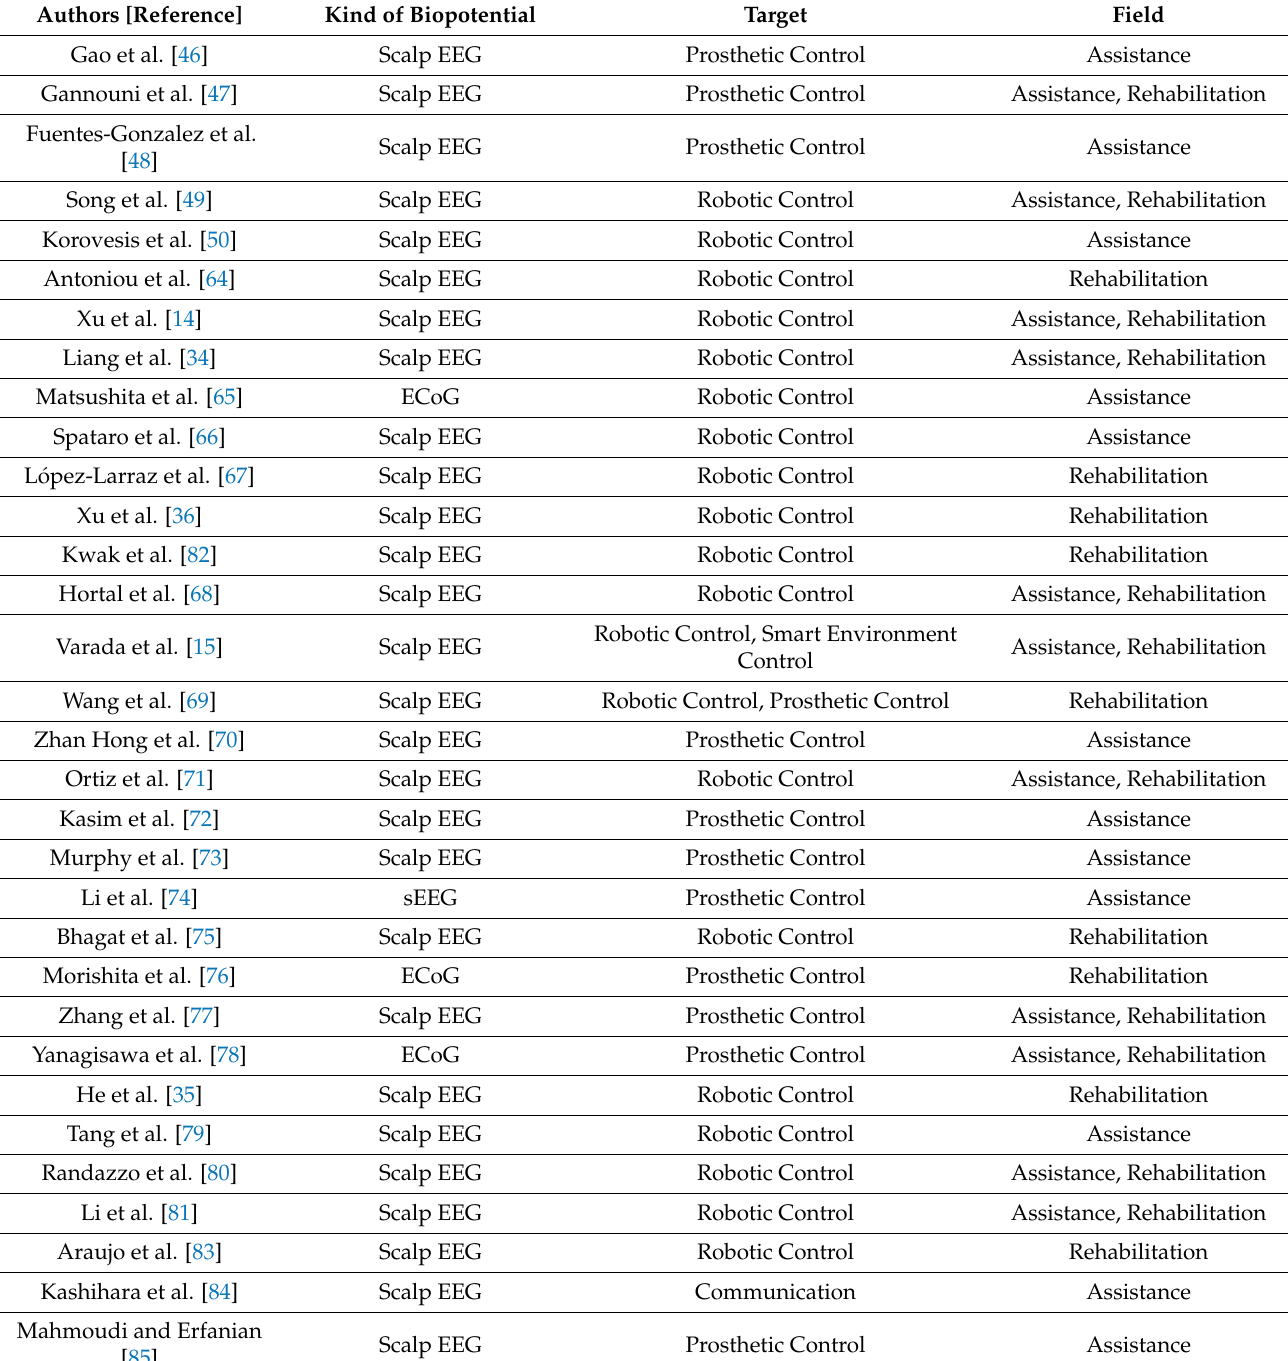
Table 2. EEG-based